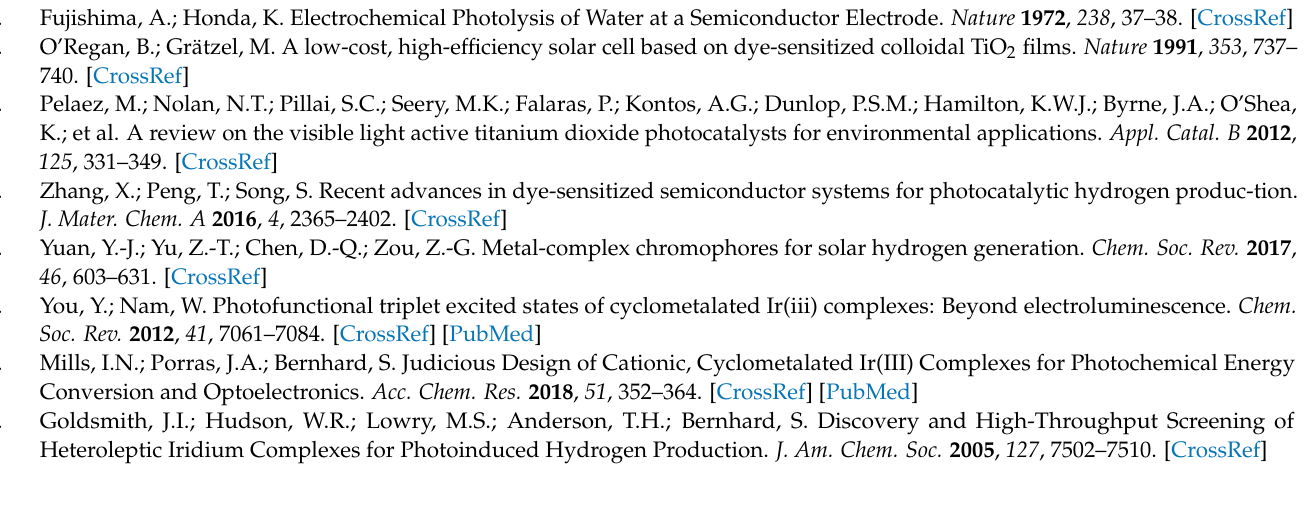
each supernatant solution and the calculated C B and M i values, Table S2: Crystal parameters and refinement data for Ir-C30, Table S3: Selected bond lengths and angles of Ir-C30, Table S4: Cartesian coordinates of the optimized Ir-C6 (cid:48) and Ir-C30 (cid:48) complexes, Table S5: Photophysical data of C6 and C30 in comparison with Ir-C30 and Ir-C6 in the solution state, Table S6: Structural comparison of the X-ray structure of Ir-C30 and optimized structures Ir-C30 (cid:48) and Ir-C6 (cid:48) by DFT calculations, Tables S7 and S8: Energy, oscillator strength and major contribution of spin-allowed transitions for Ir-C30 (cid:48) and Ir-C6 (cid:48)